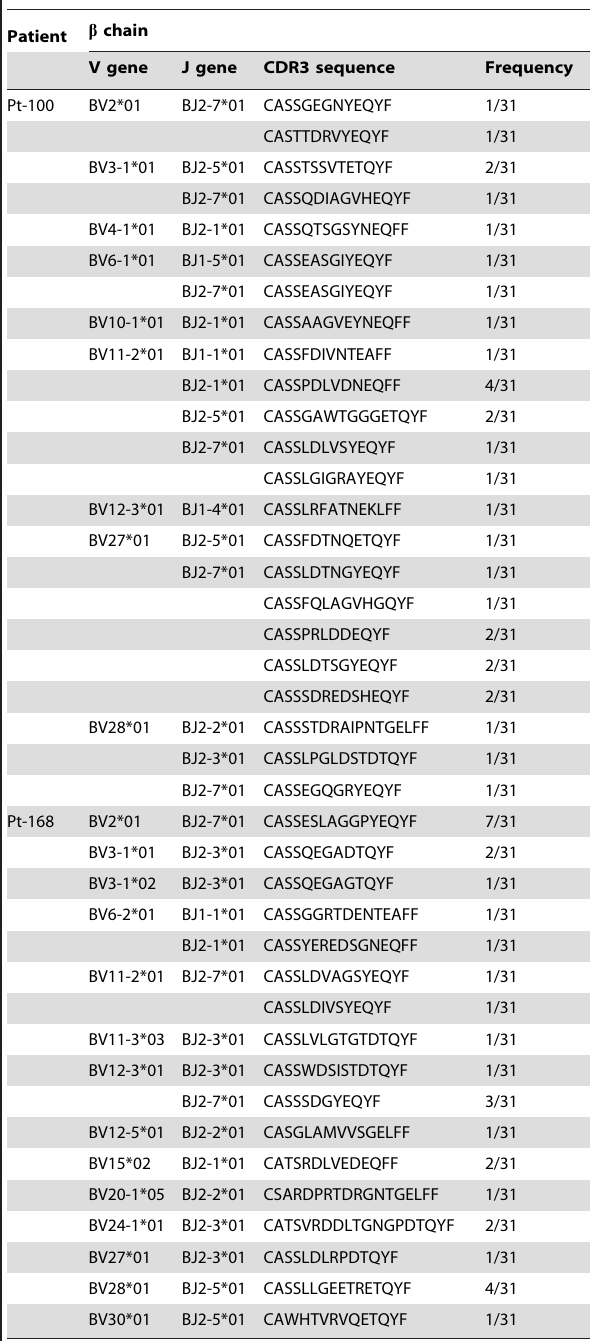
Table 1. TCR b composition of CD8 + T cell lines.